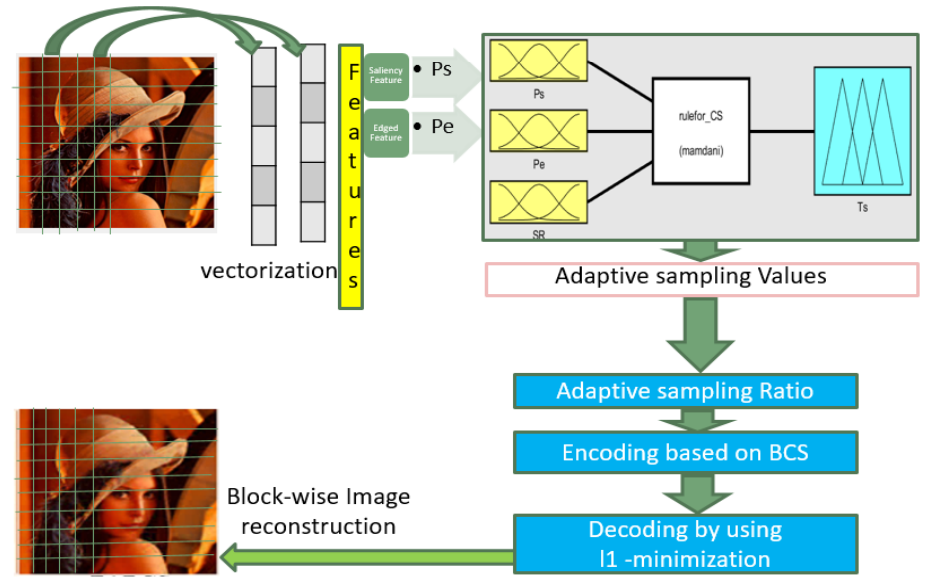
Figure 1. The Proposed Model.